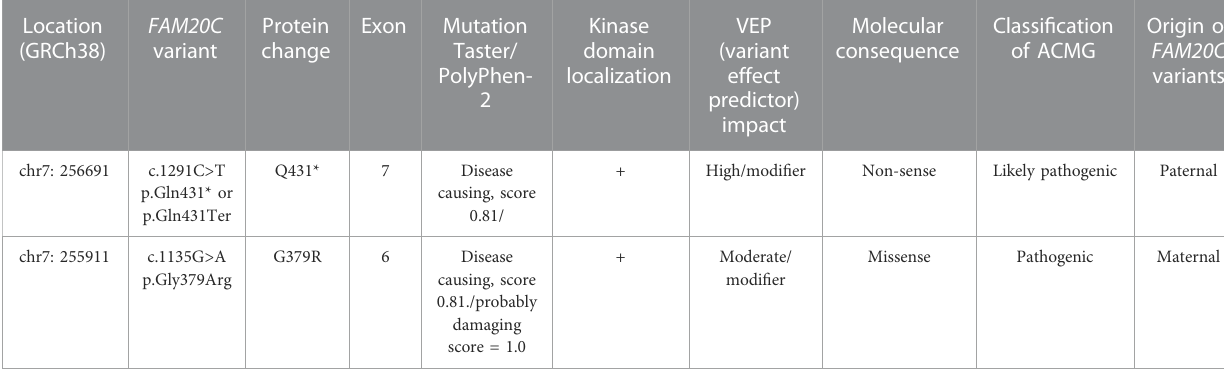
TABLE 1 The compound heterozygous variant of the FAM20C gene in our patient. Location